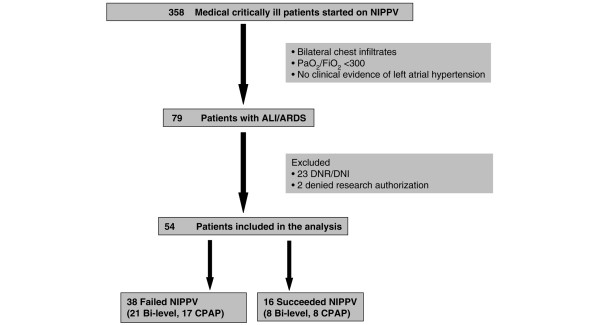
Outline of the study. CPAP, continuous positive airway pressure; DNI, do not intubate; DNR, do not resuscitate; NIPPV, non-invasive positive pressure ventilation. PaO2/FiO2, ratio of arterial partial pressure of O2 and inspired O2 concentration